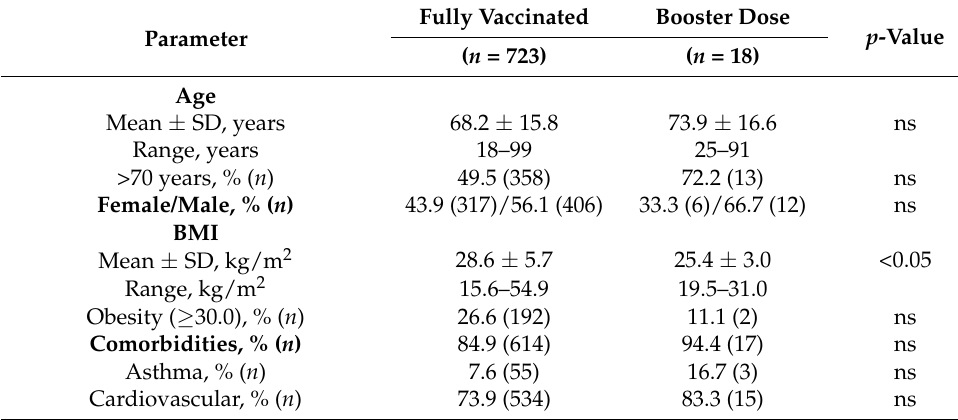
Table 1. The demographic characteristics of the studied group of vaccinated patients hospitalized with